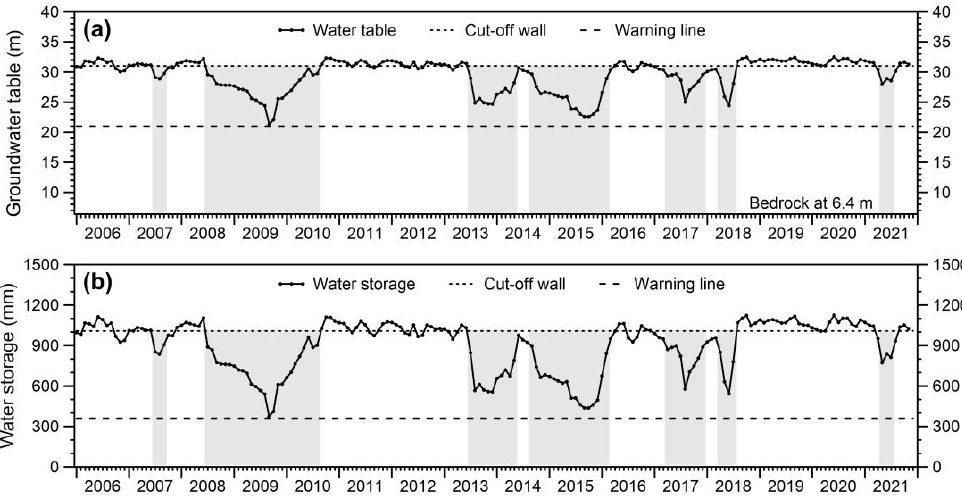
Figure 5. Changes in water table ( a ) and water storage ( b ) for the period from January 2006 to July 2021. The gray shadow in the figure indicates that the groundwater table is below 30 m.